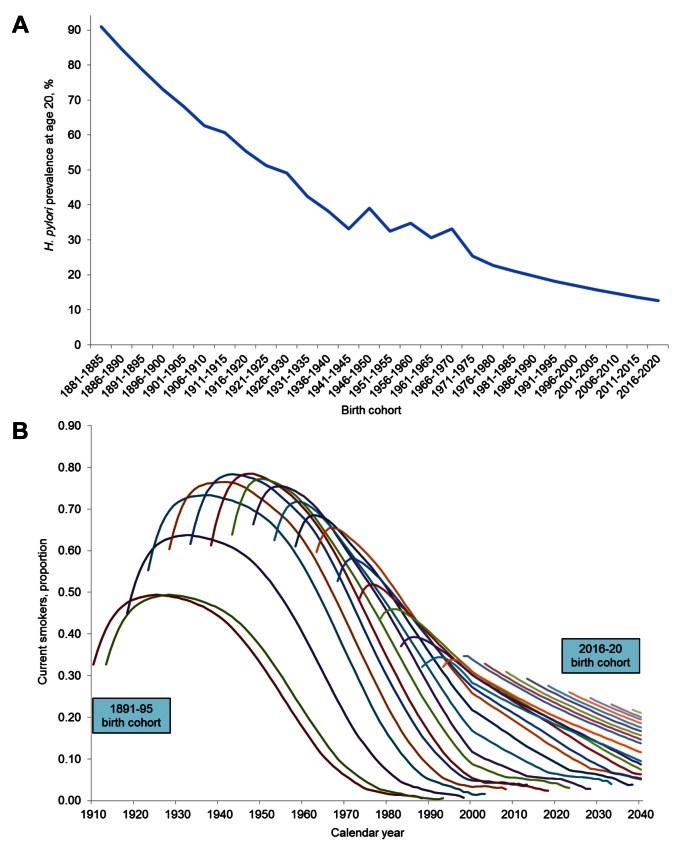
Birth cohort risk factor profiles.(A) H. pylori prevalence at age 20 for birth cohorts between 1881 and 2020 based on NHANES III and Continuous NHANES (1999–2000) data. For pre-1900 and post-1980 birth cohorts for which data were unavailable, we extrapolated the observed 7.1% rate of decline between successive 5-y birth cohorts between the 1901–1905 and 1976–1980. (B) The proportion of current smokers by 5-y birth cohorts between 1891 and 2020 (starting at age 20). For birth cohorts born after 1983 (and cohorts with individuals still alive past calendar year 2000) for which data from the NHIS-based Smoking History Generator were unavailable, we extrapolated observed trends and extended profiles until all individuals either died or reached 100 y of age. Specifically, for post-1983 birth cohorts, we assumed that smoking rates peaked at age 20, initiation rates declined by 5.7% every 5 birth cohort years, and the annual risk of cessation remained constant at 2% [54],[55].